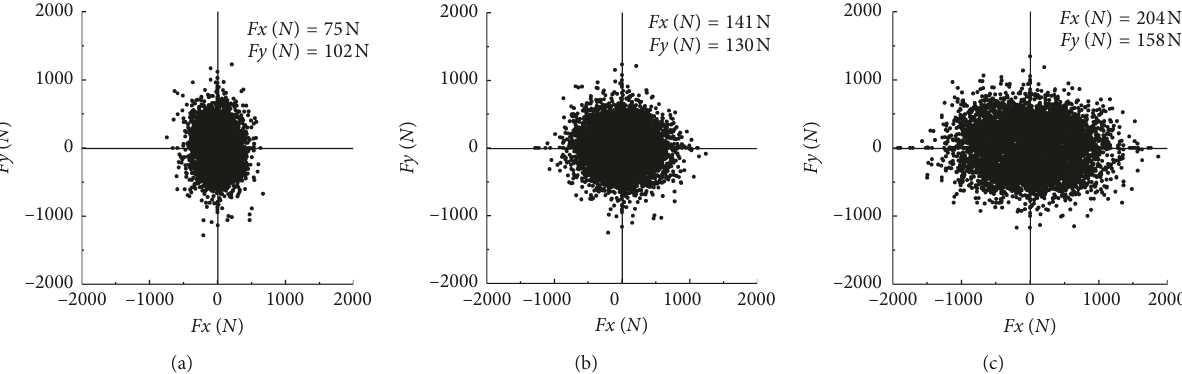
Figure 12: Distribution of the particle normal contact force and direction during the process of sample F1 loading: (a) ε 0 . 8%. (c) ε 3 (cid:30)